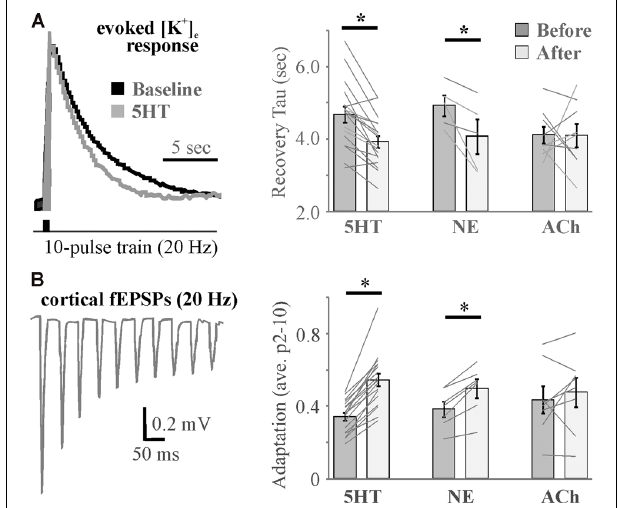
FIGURE 6 | Differential effects of neuromodulators on evoked increases in extracellular potassium mirror differential neuromodulator effects on adaptation. (A) Example traces (left) and histograms (right) showing activity-induced recovery decay tau is accelerated by 5HT and NE, but not ACh. (B) A 10-pulse train shows significant spike frequency adaptation in the somatosensory cortex (left) that is differentially regulated by neuromodulators (right). N = 5–18. ∗ < 0.05 by repeated-measures ANOVA with Fisher’s LSD post hoc . Data and figures were adapted from Wotton et al. (2020) with